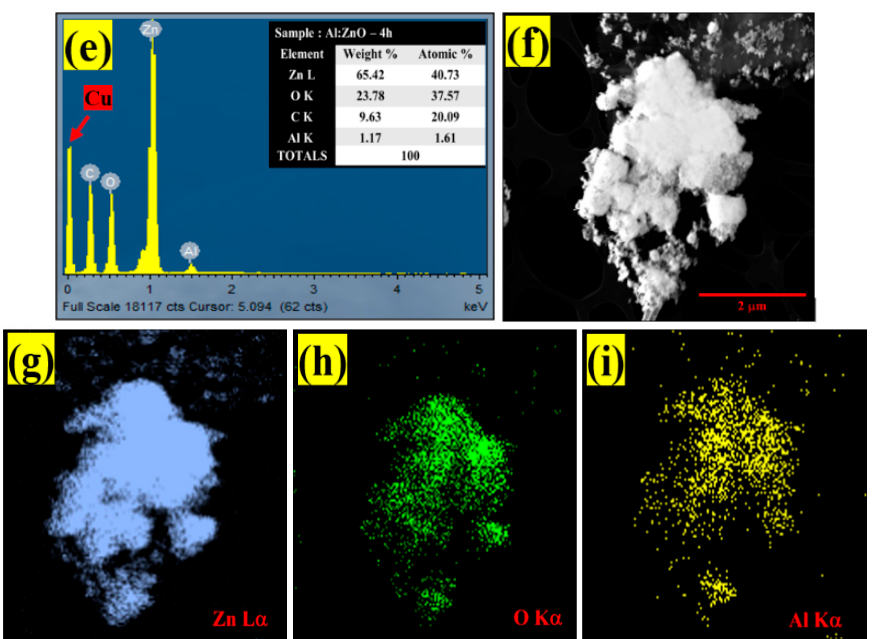
Figure 9. EDS spectra of: ( a ) pristine ZnO and ( e ) Al:ZnO-4 h. EDS elemental mapping of ( b – d ) pristine ZnO and ( f – i ) Al:ZnO-4 h.